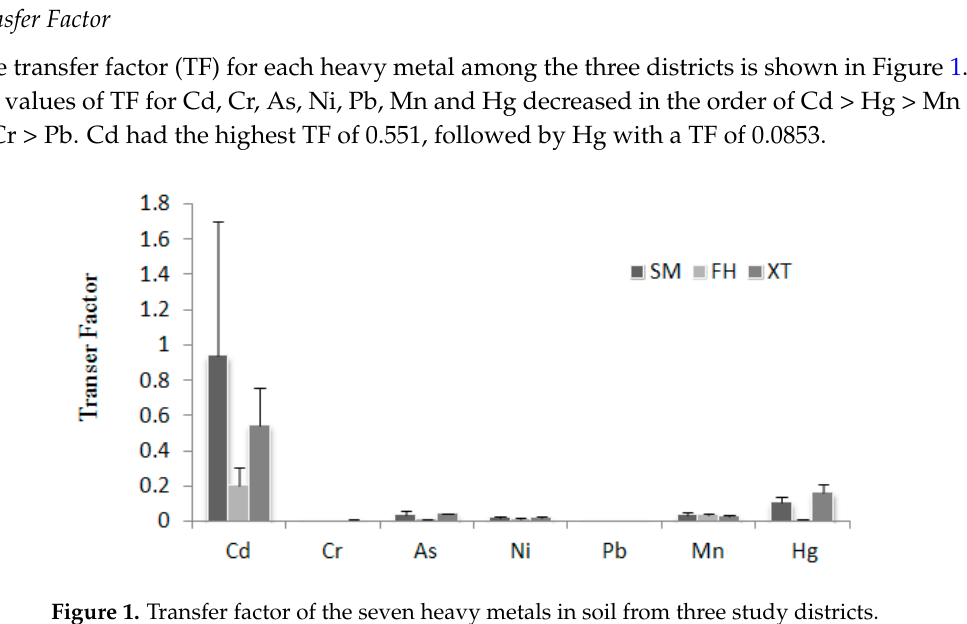
Figure 1. Transfer factor of the seven heavy metals in soil from three study districts.